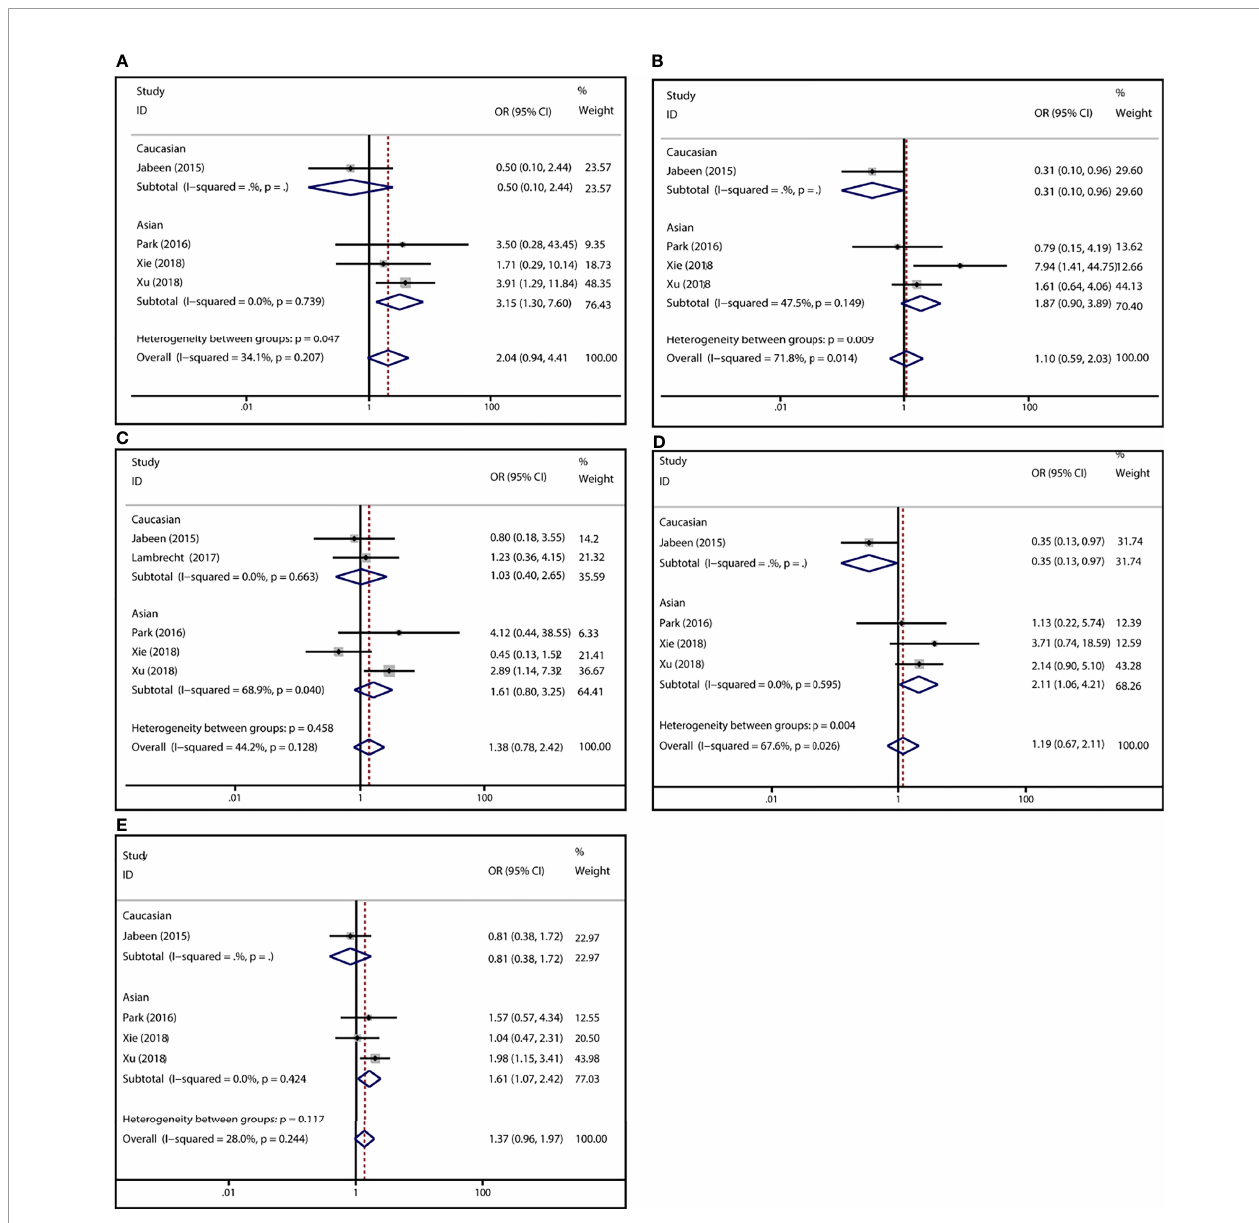
FIGURE 2 | Forest plots for the association between MTX-induced liver toxicity and MTHFR rs1801133 polymorphism. (A) homozygote comparison TT vs. CC; (B) heterozygote comparison TC vs. CC; (C) recessive genetic model TT vs. TC/CC; (D) dominant genetic model TT/TC vs. CC; (E) allele contrast T vs.